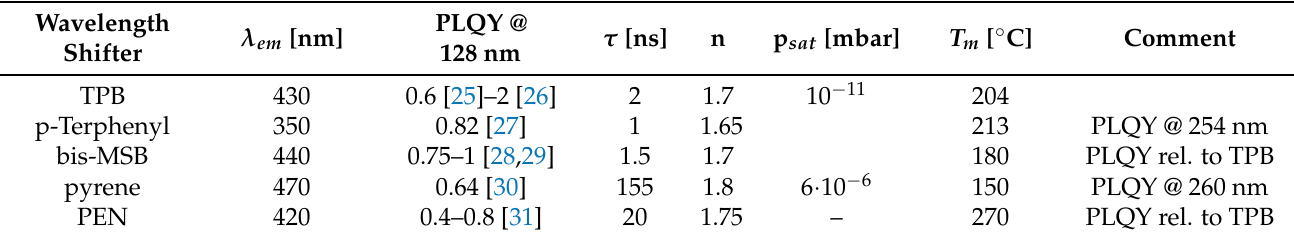
Table 1. Fundamental properties of common WLS materials used in LAr detectors: peak emission wavelength ( λ em ), PLQY, re-emission lifetime ( τ ), refractive index ( n ), vapour pressure ( p sat ), and approximate sublimation temperature ( T m ).